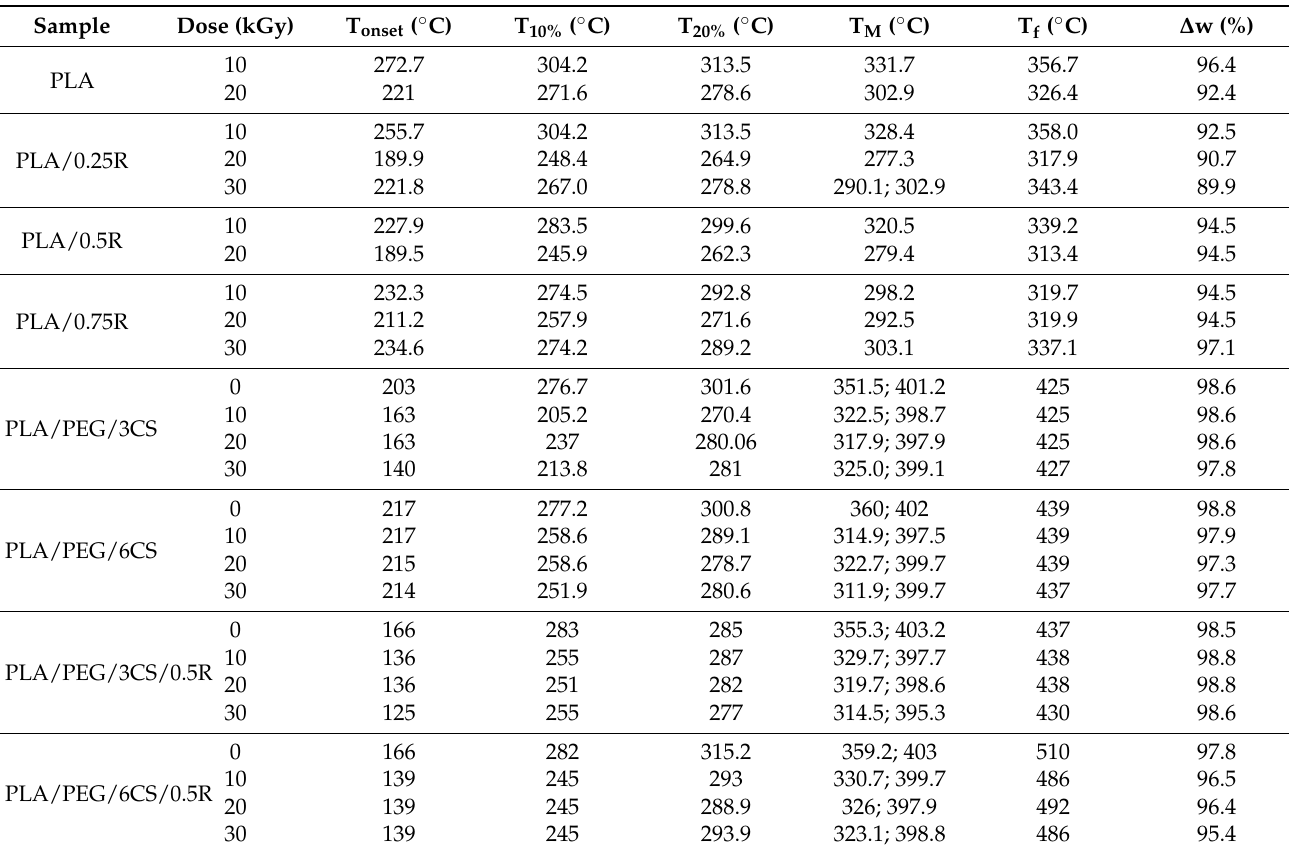
Table 3. TG data of PLA-based samples irradiated at different